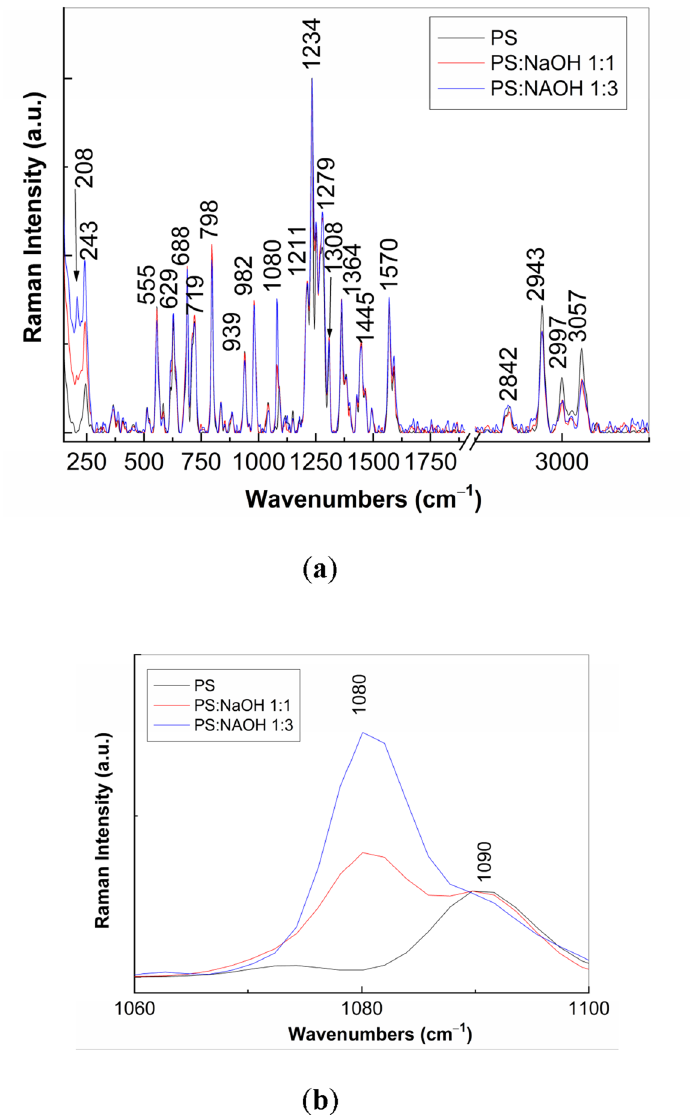
Figure 12. Raman spectra, in the 100–3500 cm −1 ( a ) and 1060–1100 cm −1 ( b ) spectral ranges, of PS ( 1 ) (curve black) and NaOH-reacted PS ( 1 ), when the weight ratio between PS ( 1 ) and NaOH was of 1:1 (red curve) and 1:3 (blue